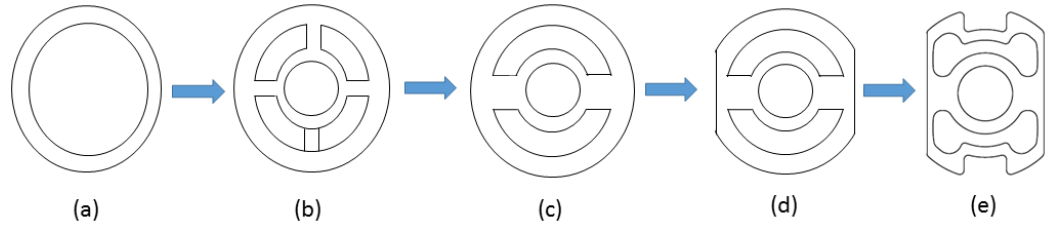
Figure 4. Evolution SCTS geometry which started from ( a ) hollow shaft; ( b ) hub-sprocket four spoke; ( c ) hub-sprocket two spokes; ( d ) square-cut hub-sprocket with two spokes to ( e ) optimized